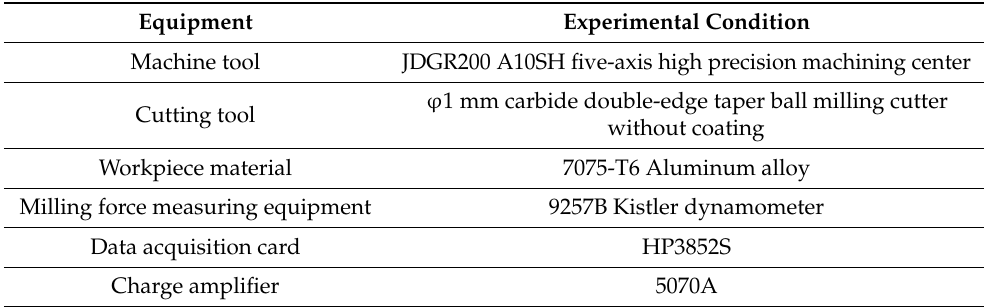
Table 4. Experimental equipment